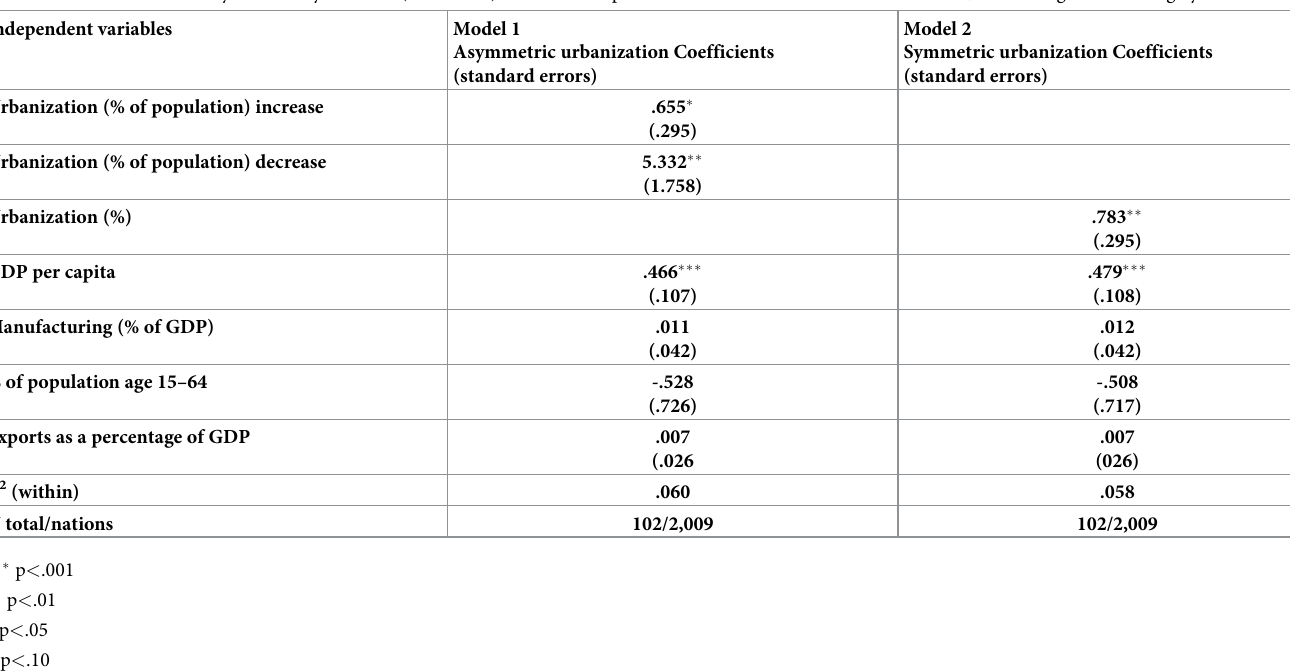
Table 1. Principal models. Generalized least-squares panel regression models of the influence on CO 2 per capita in LDCs, 1960–2010. All variables are in natural logarith- mic form. All models include year dummy variables (not shown) to control for period effects. The standard errors are robust, accounting for clustering by